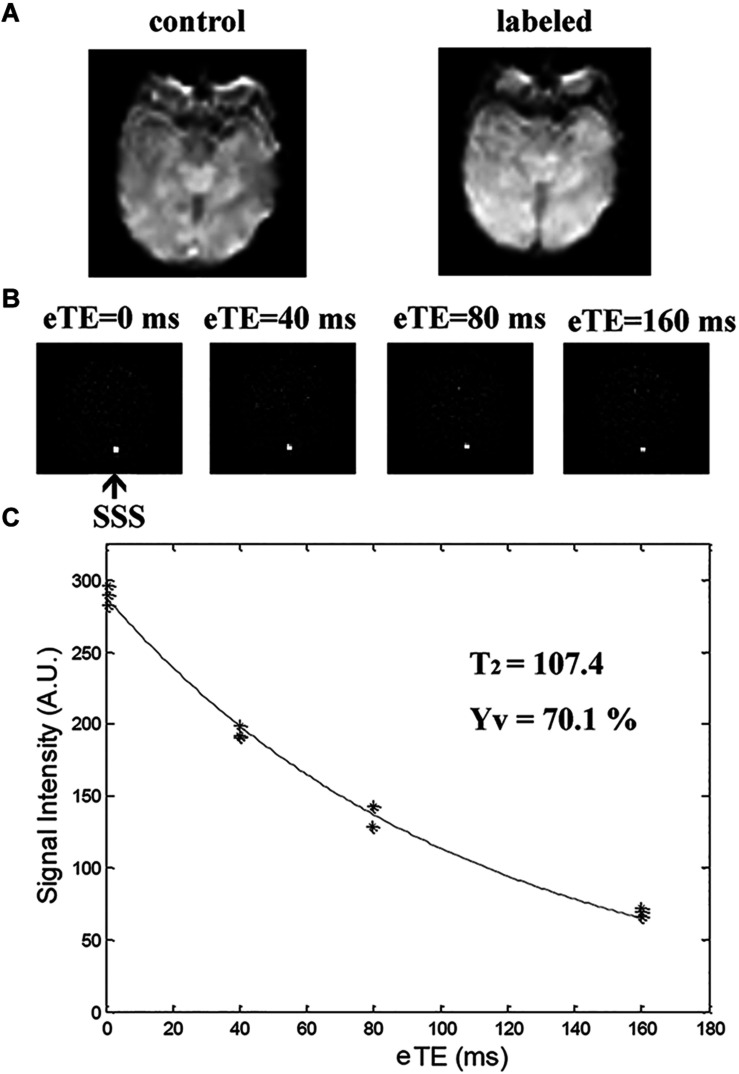
T2-relaxation-under-spin-tagging (TRUST) MRI for quantifying venous oxygenation (Yv) in superior sagittal sinus (SSS). (A) Raw images of control and labeled scans; (B) Various images (i.e., control-labeled) as function of T2-weighting [effective echo times (eTEs) of 0, 40, 80, and 160 ms; black arrow at SSS); and (C) Blood signals in SSS of TRUST MRI fitted to monoexponential function of eTE to yield blood T2, in turn converted to Yv via calibration plot.